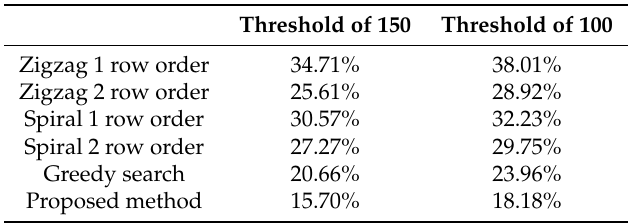
Table 5. Comparison results of percentage re-covered area from the heat-map, with different simulation environment